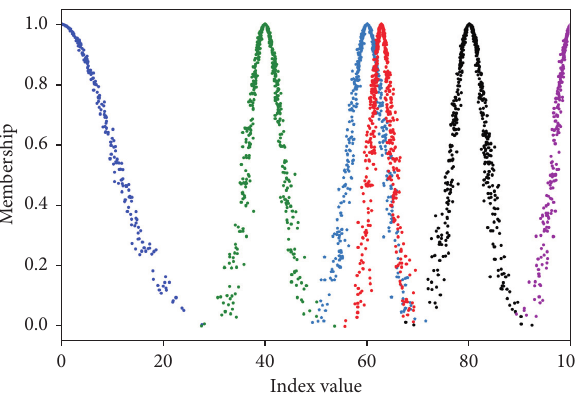
Figure 10: Cloud map of total project